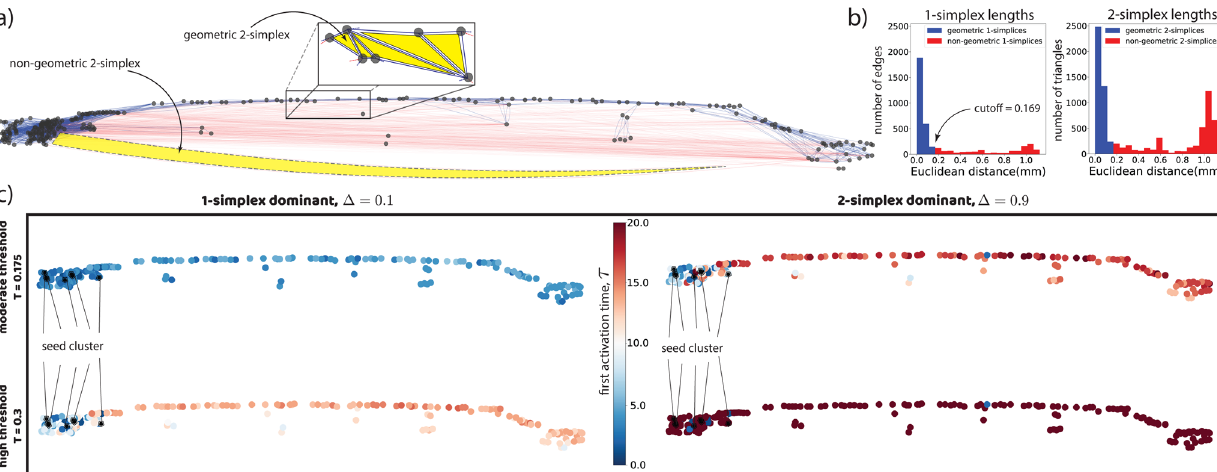
Fig. 3 Simplicial threshold model cascades on a C. elegans neuronal complex. a 2D visualization of experimentally measured locations and synapse connections between neurons in nematode C. elegans 78,79 . We model higher-order nonlinear dynamical dependencies among sets of ( k + 1) neurons using k -simplices in the associated clique complex for which we ignore edge directions. b Histograms depict the distribution of lengths for 1- and 2-simplices, where we de fi ne the length of a 2-simplex as the maximum length over its faces. We distinguish geometric and non-geometric 1-simplices by selecting a cutoff distance of 0.169 mm, and we characterize a 2-simplex as geometric if and only if all of its faces are geometric. c Vertex colors depict their fi rst- activation times τ i for a 2D STM cascade that is initialized with the indicated seed cluster. Observe that T and Δ affect the spatio-temporal pattern of activations (i.e., wavefront propagation and appearance of new clusters) similarly to what was shown in Fig.